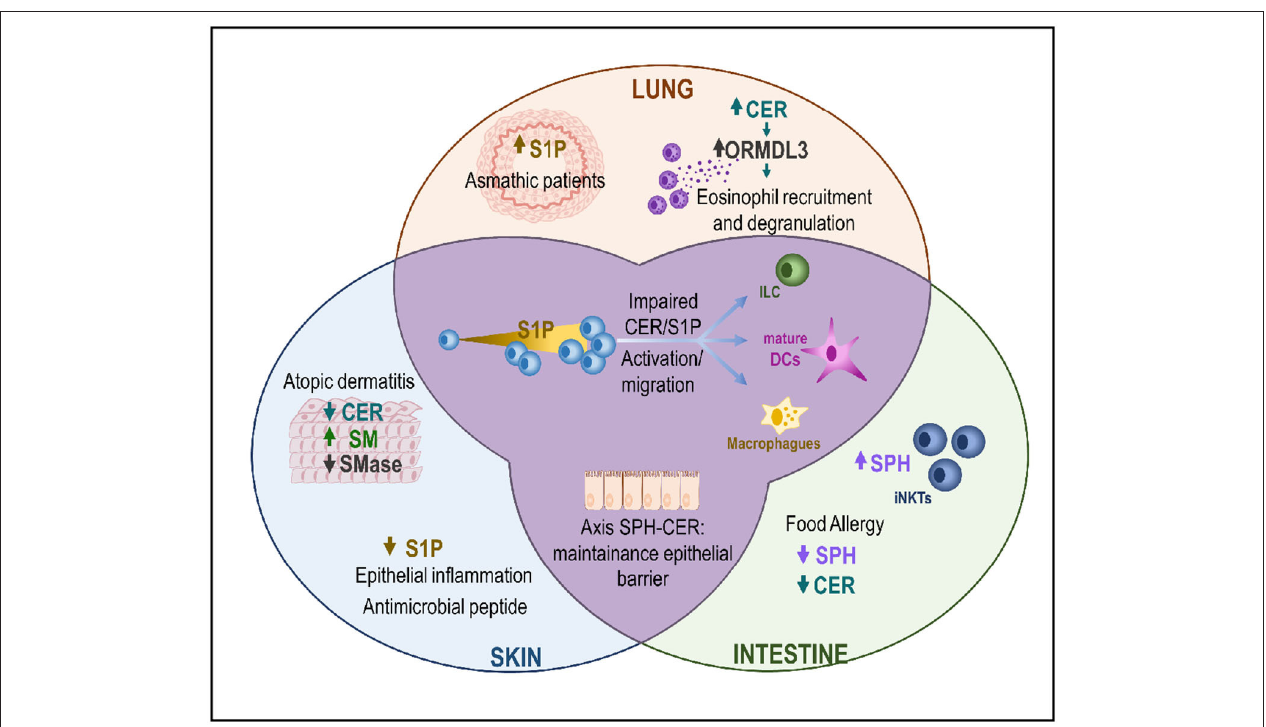
FIGURE 2 | The CER/S1P axis in the MALT. Changes in the CER/S1P ratio triggers activation and migration pathways in ILCs, dendritic cells, and macrophages. This axis plays a role in different compartments of the MALT (skin, lung, and/or intestine) with different organ-dependent results. In the skin, downregulation of CER and SM causes increased permeability, which is associated with a higher penetration of bacteria and/or allergens, which in turn will increase inflammation. In the lung, asthmatic patients show higher levels of S1P. This disease is tightly related to increased ORMDL3 expression, with a concomitant increase in the CER levels and eosinophilia. Finally, in the intestines, decreased levels of sphingolipids and S1P are associated with the development of FA in patients. CER, Ceramide; DC, Dendritic cells; ILC, Innate lymphoid cells; iNKTs, invariant natural killer T cells; SM, Sphingomyelin; SMase, Sphingomyelinase; S1P, sphingosine-1-phosphate; SPH, Sphingosine; ORMDL3, Orosomucoid-like 3; FA, Food